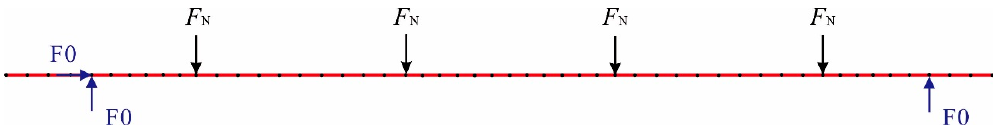
Figure 22. Finite-element model of the beam for structural analysis.